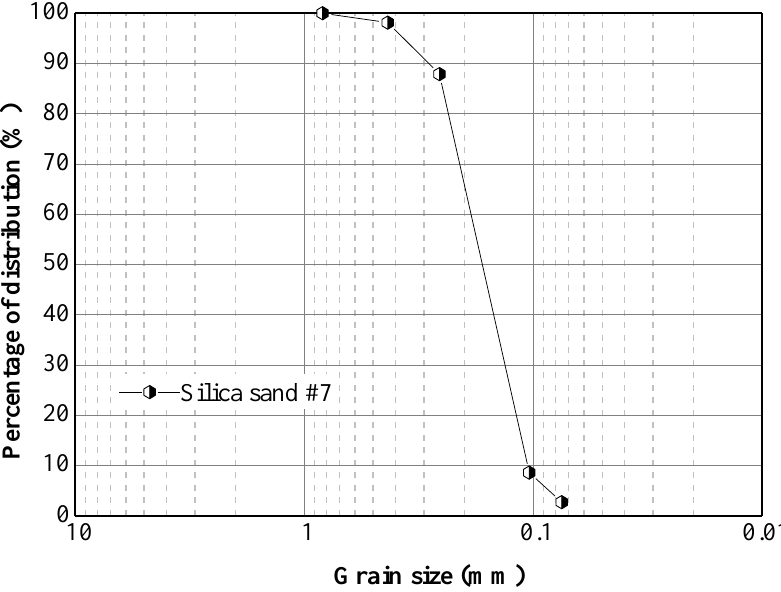
Figure 1. Particle size distribution of silica sand number 7. The slope model composed of two different layers with specified densities was built by tamping, and the initial moisture content is 10%. A pre-designed irregular circular slip surface with different radiuses was set between these two layers as shown in Figure 2. The radius of the slip surface of the upper part was 300 mm, and it was 800 mm in the lower part. After making the slope model at horizontal position, this slope model was inclined to a target angle about 40 degrees before artificial rainfall with the rainfall intensity of 70 mm/h applied. The intensity of artificial rainfall was controlled by a rainfall system, which was composed of a nozzle, a water tank and an air pressure cylinder. Two tilt sensors and extensometers which are noted by “T” and “E” were exploited in this test with the accuracy of 0.1 degree and 0.1 mm to measure the pre-failure tilting behavior and the surface displacement of the slope as indicated in Figure 2.